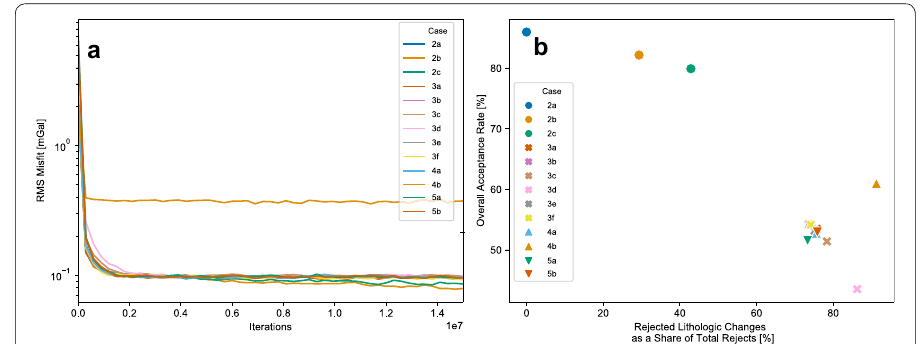
Fig. 7 Summary statistics for different inversion runs. a Evolution of root mean square (RMS) misfit between forward-modeled and observed gravity field over the MCMC inversion process for different inversion runs. b Overall acceptance as a function of the number of lithologic changes rejected as a share of total rejections, expressed as a